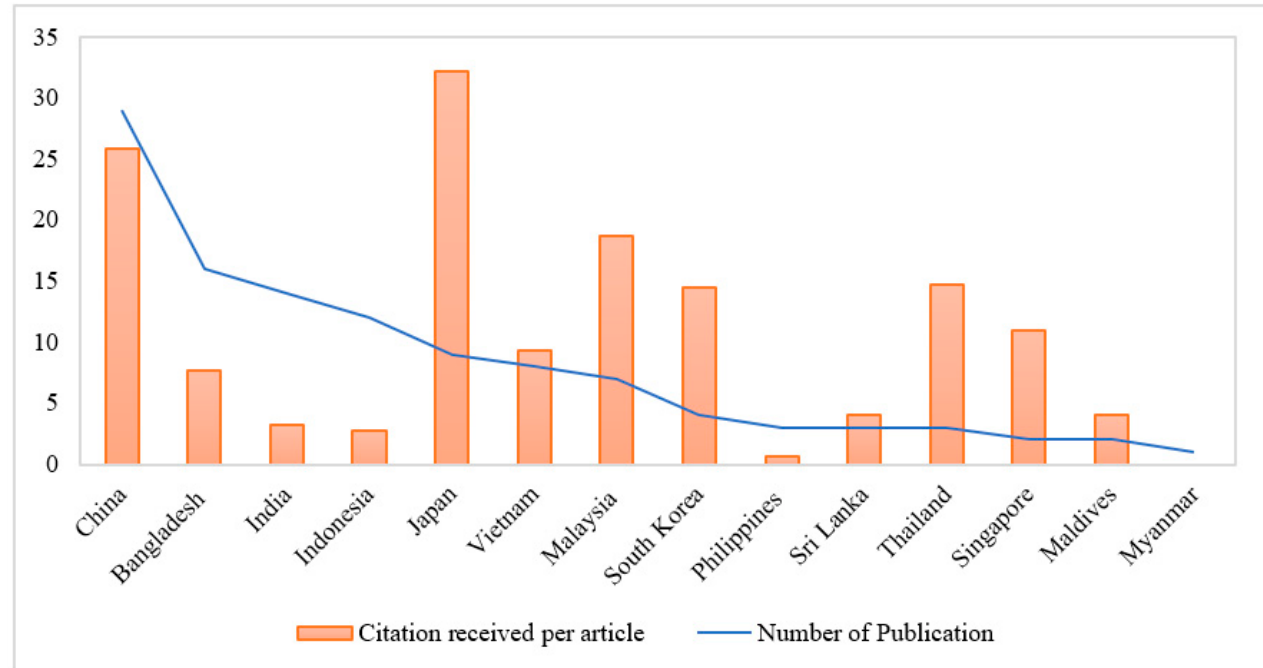
Figure 4. The number of publications and citation impact per publication by research country (2010 to 2022).